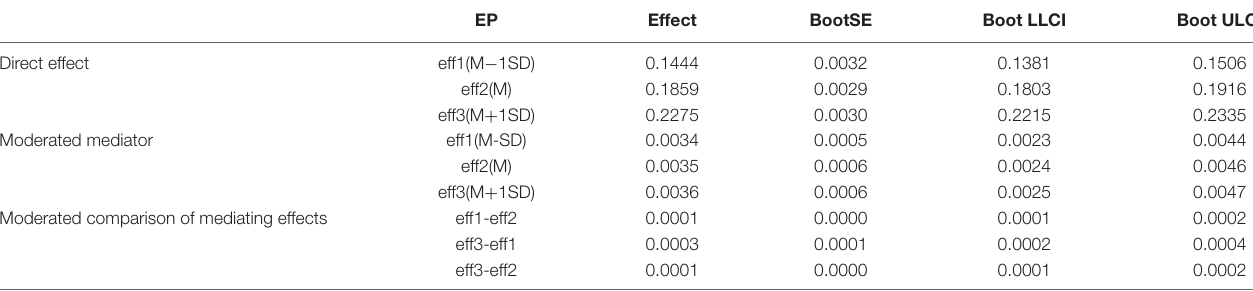
TABLE 7 | Direct effect and mediating effect at different levels of entrepreneurial